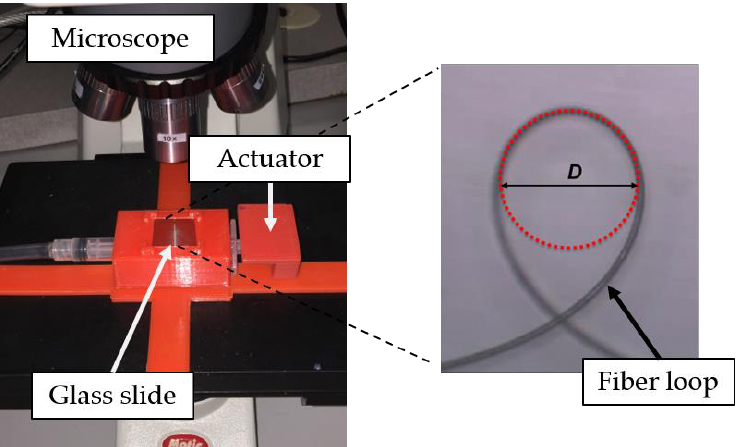
Figure 3. An example of observing glass fiber breakage under microscope level in a loop test.